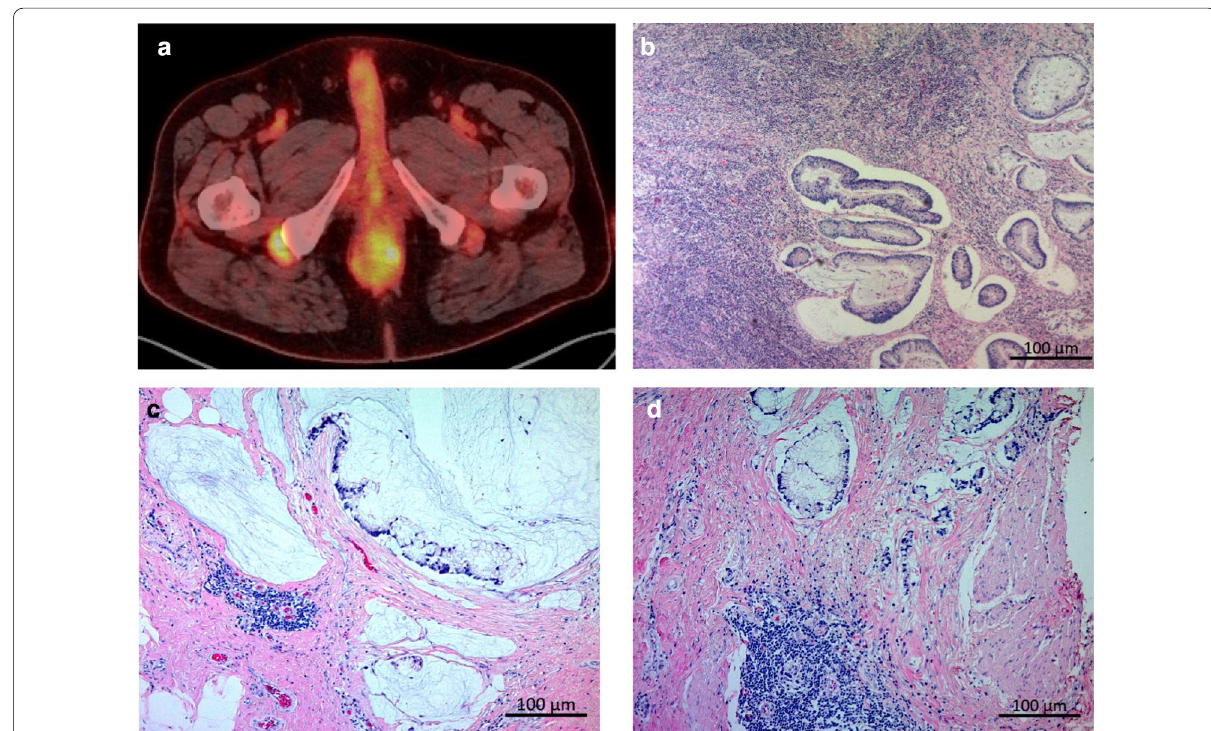
Fig. 1 The findings of [ 18 F]-fluoro-2-deoxy- d -glucose (FDG)-positron emission tomography/computed tomography (PET/CT) ( a ) and Hematoxylin– eosin staining of resected specimen ( b , c , d ) in the presented case of mucinous adenocarcinoma (case 7). a PET/CT image shows abnormal accumulation of FDG in the tumor. b Tumor cells are found floating in the abscess derived from the anorectal fistula. c Rich mucinous production is found in the tumor. Infiltration of inflammatory cells was also observed around the tumor. d The infiltration of many inflammatory cells was found around the tumor